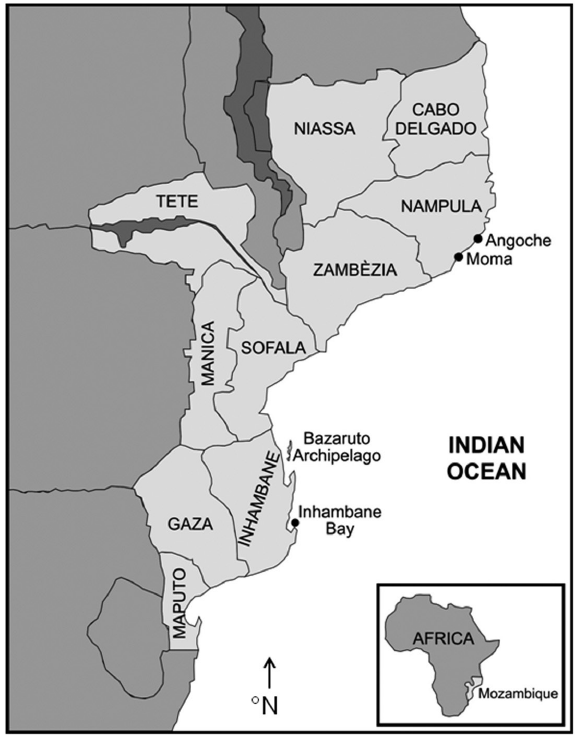
Fig. 1. – Map of the study area, with the different provinces and prin- cipal fishing centres where the sampling was carried out. The full list of the fishing centres used in the analysis is reported in Table